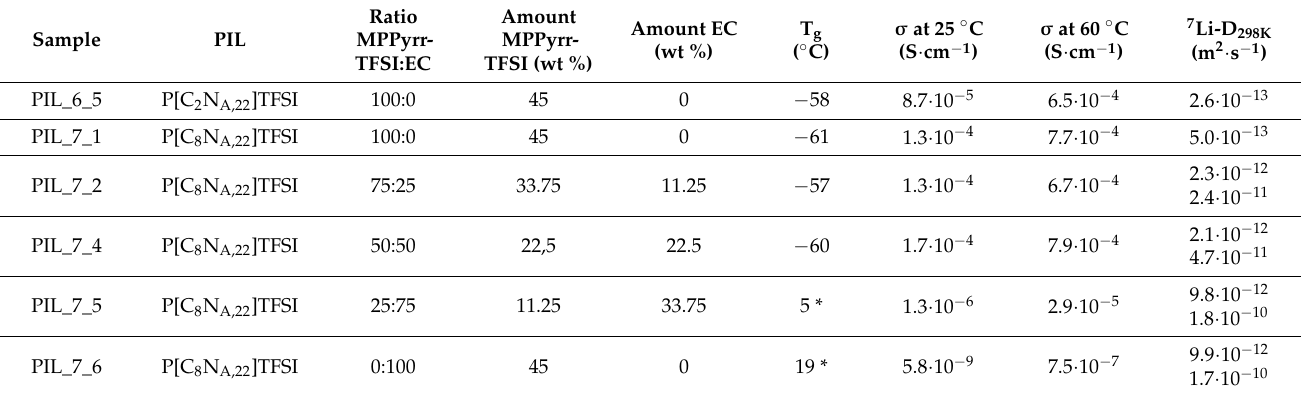
Table 2. Glass transition temperatures T g , ionic conductivity values σ at 25 ◦ C and 60 ◦ C as well as the diffusion coefficients D of 7 Li at 25 ◦ C in dependence of the PIL and the ratio of MPPyrr-TFSI to ethylene carbonate (EC). Sample